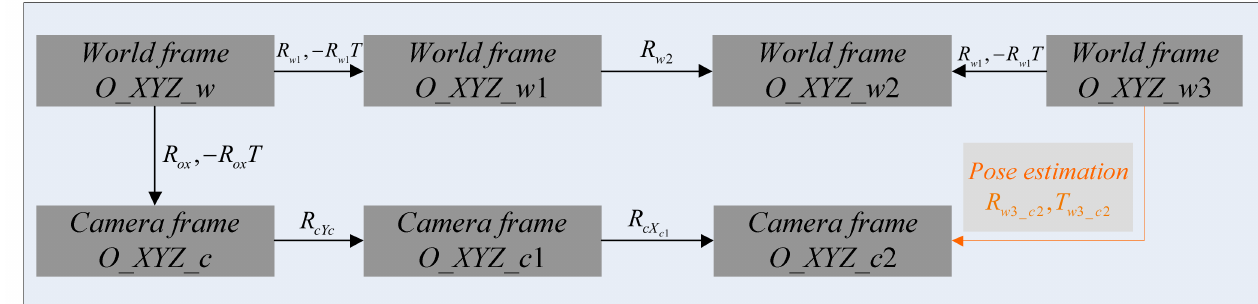
Figure 7. Transformations of all the frames. The transformation (yellow) between the world frame O_ZYZ_w 3 and the camera frame O_ZYZ_c 2 is unknown and needs to be estimated, while the other transformations have been